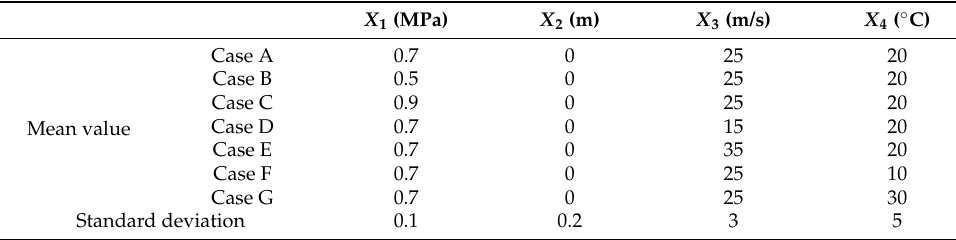
Table 5. Random variables with different mean values.